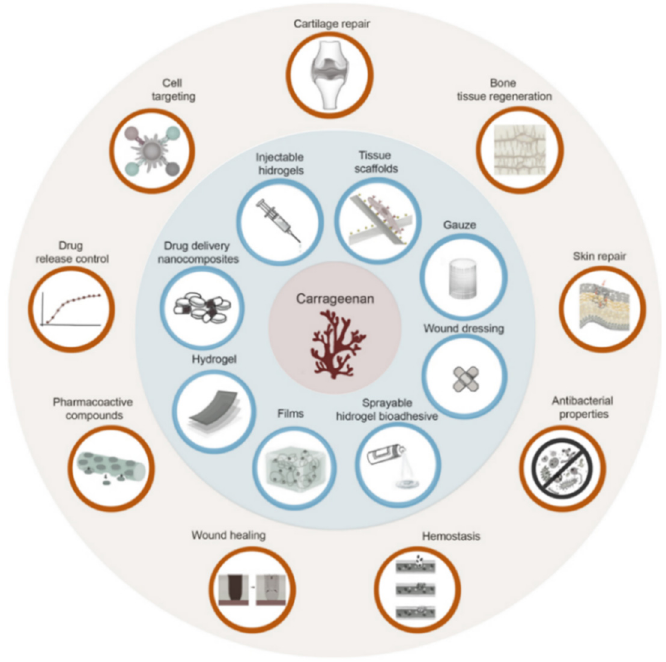
Figure 1. Applications (blue background) and biological uses or properties (red background) of carrageenan-based formulations.